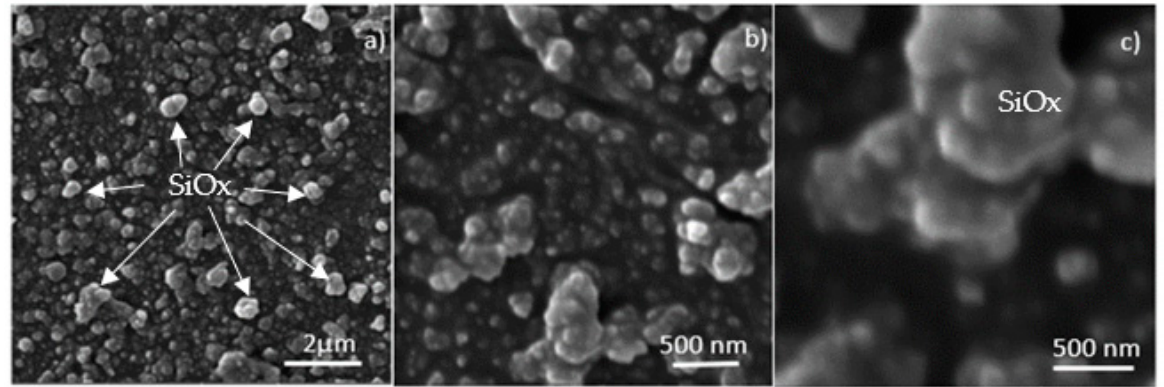
Figure 6. SEM images with magnification 20.8 k × ( a ), 69.2 k × ( b ), 208 k × ( c ) of layers deposited by LIBT on PDMS substrates.